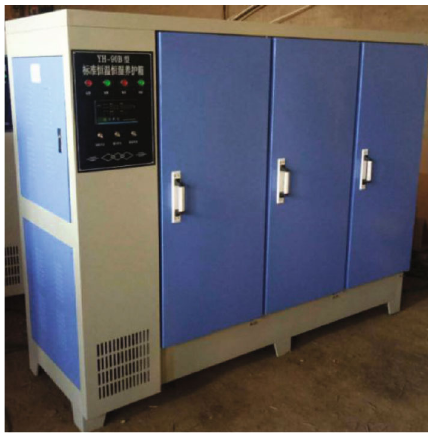
Figure 1: Alkali aggregate reaction curing box.